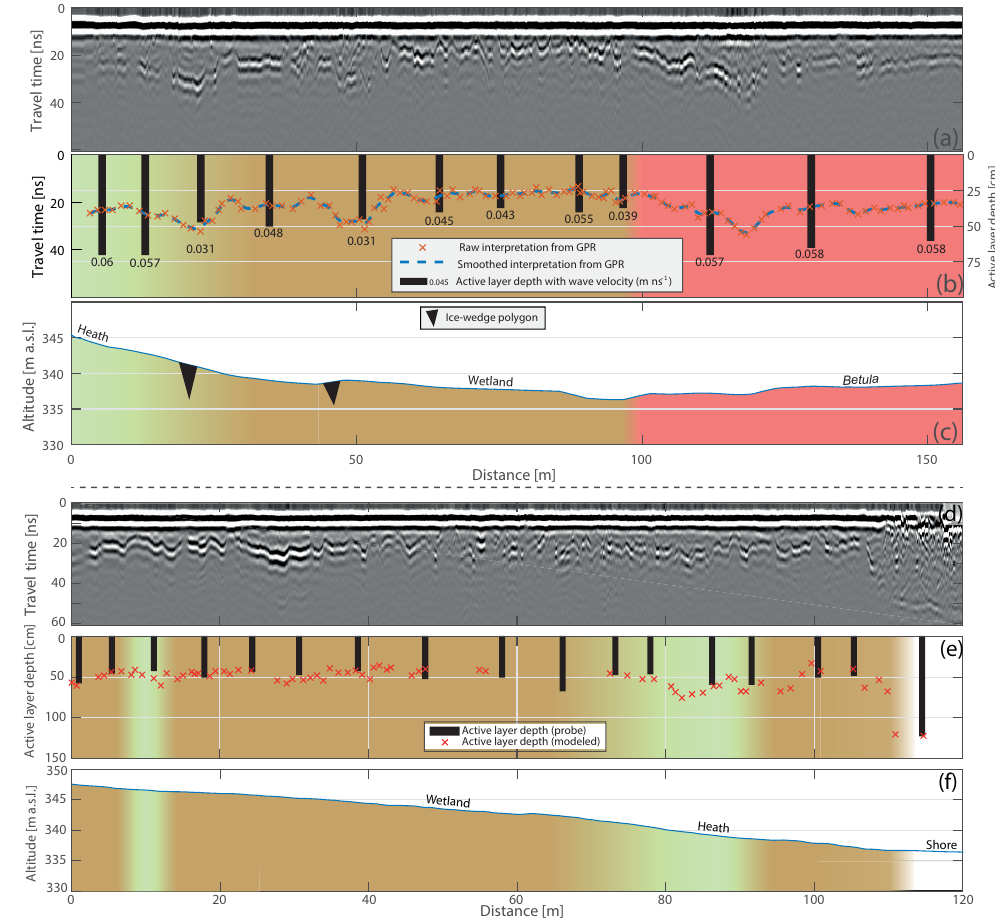
Figure 4. Profile 1 (Fig. 3b) with (a) the raw data from the GPR, (b) probe depths to permafrost and selected permafrost reflectors from the raw data. Values below probe bars represent the calculated electromagnetic wave velocity at the probe locations and surface vegetation classes as background. (c) Elevation, permafrost features and vegetation. Profile 2 (Fig. 3b) with (d) raw data from the GPR, (e) probe depth to permafrost with modeled depth from raw data and Table 2 as well as vegetation classes in the background. (f) Surface altitude and vegetation along